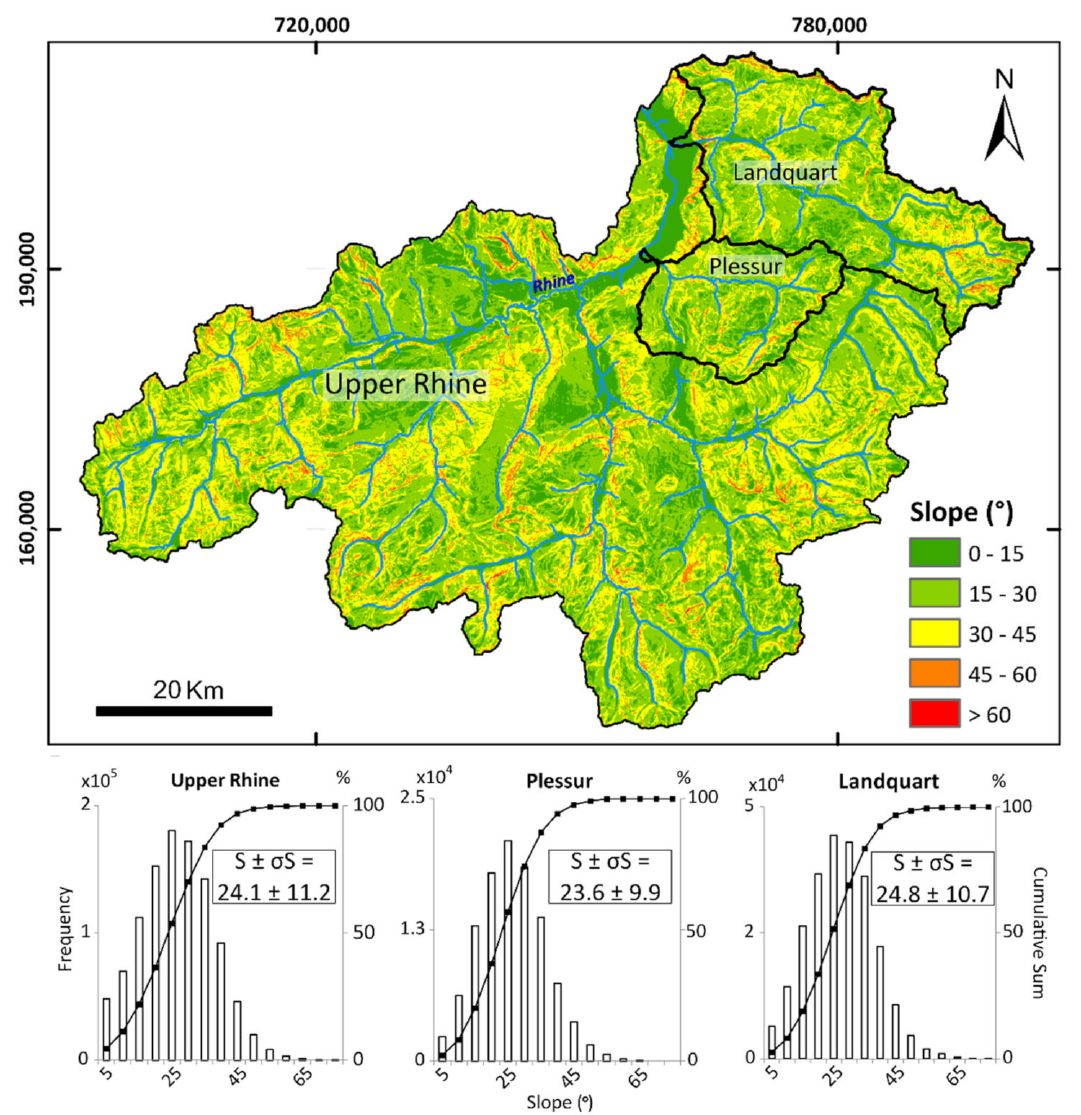
Figure 8. Slope distribution of the Plessur, Landquart, and Upper Rhine basin. The slope histograms of each basin display the slope averages in degrees ( ◦ ), the associated uncertainties, and the cumulative sums in percentage (%). The numbers at the border of the figure indicate the Swiss coordinates in